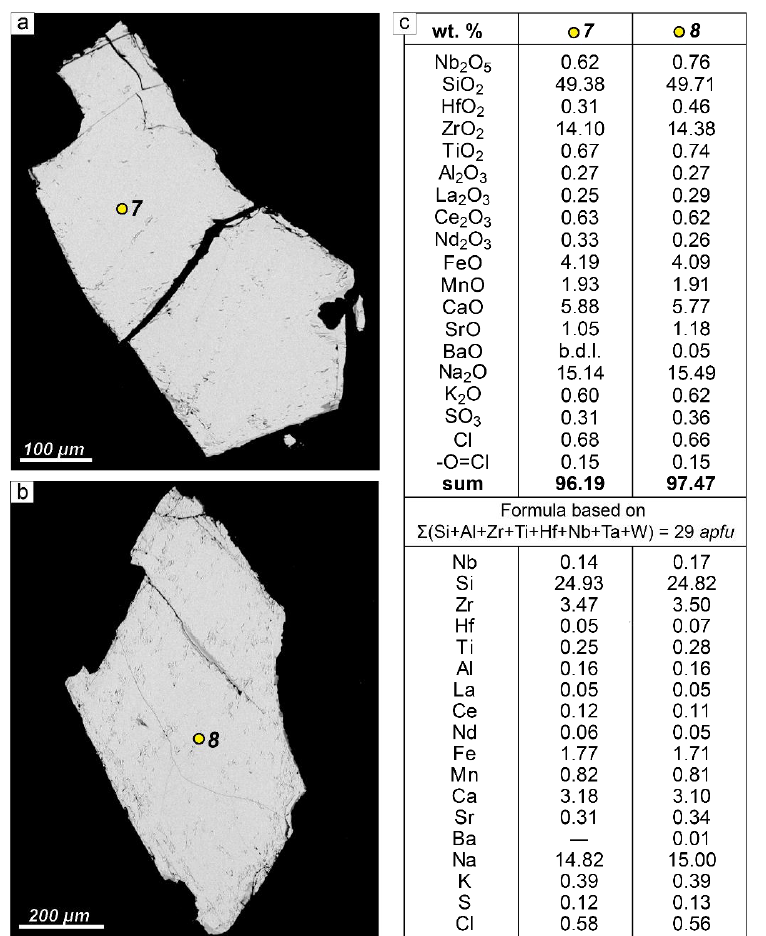
Figure 5. The morphology and representative chemical analysis of EGM grains separated from the sample LV-604/2 (sampling point 3 in Figure 1 а ) for the experiments. ( a , b ) Grain morphology; BSE images; yellow dots are microprobe analysis points; ( с ) chemical compositions of EGM grains shown in Figure 5a,b; apfu — atoms per formula unit; b.d.l. — below detection limit.